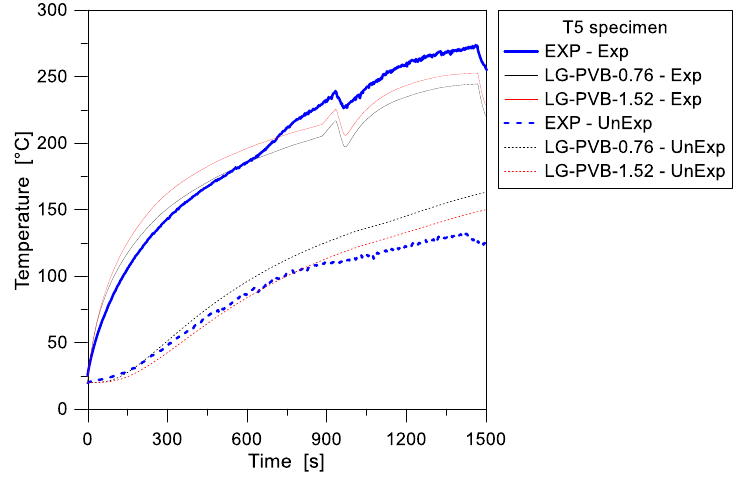
Figure 9. Temperature history comparisons for the LG specimen T5, as obtained from the FE parametric analyses (ABAQUS, 1D) and the past experimental test.